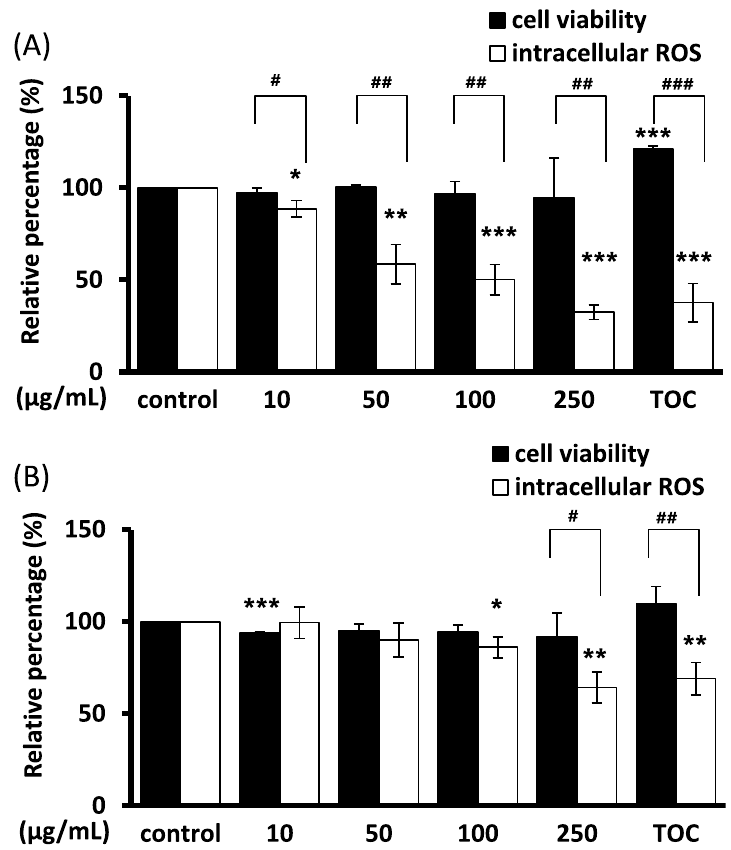
Fig. 3 Intracellular reactive oxygen species (ROS) scavenging activity of B. formosana callus extract. A Relative DCFH‑DA fluorescence in Hs68 fibroblast cells. B Relative DCFH‑DA fluorescence in HaCaT keratinocytes. 0.03% tocopherol was used as the positive control and presented as TOC. Data are presented as means SD of triplicate experiments. * p < 0.05, ** p < 0.01, and *** p < 0.001 compare with control. # p < 0.05, ## p < 0.01, and ± ### p < 0.001 compare with relative cell viability of the same